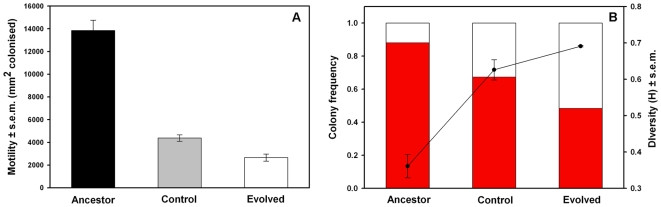
The mean motility (panel a) and diversity (panel b) of different bacterial strains.In panel a, ancestor versus control strain (P = 0.001), ancestor versus evolved strain (P<0.001) and control versus evolved strain (P = 0.014), N = 3 for every strain. In panel b, the mean colony frequencies (bars) and diversity (line) of different bacterial strains determined on the basis of the synthesis of red pigment, prodigiosin.